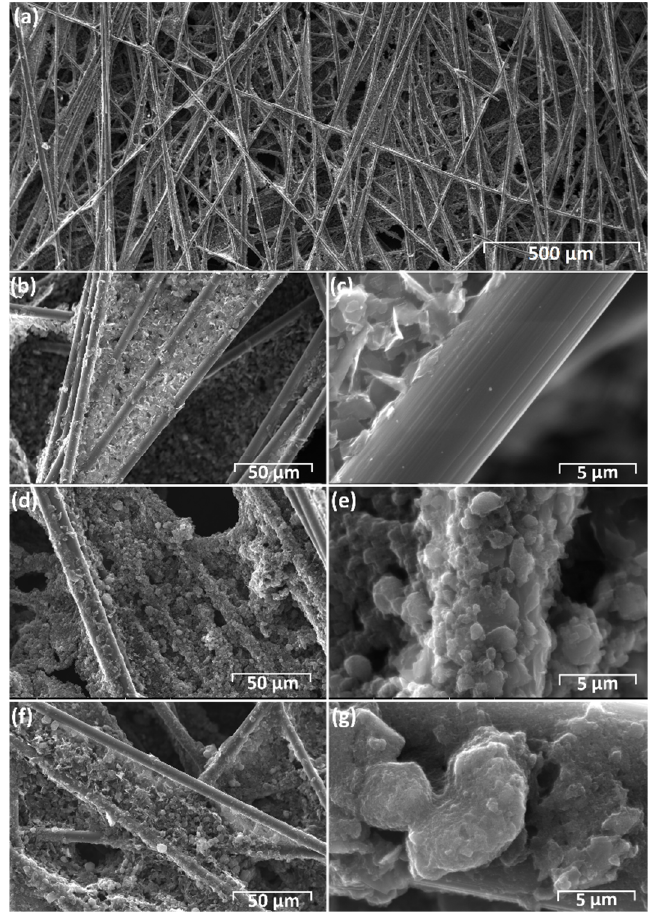
Figure 2. SEM images of 29AA carbon paper: ( a – c ) as received, ( d , e ) CB-modified electrodes, and ( f , g ) GnP-modified electrodes. Accelerating voltage, 20 kV. Spot size, 3.0. Working distance, 10 mm.